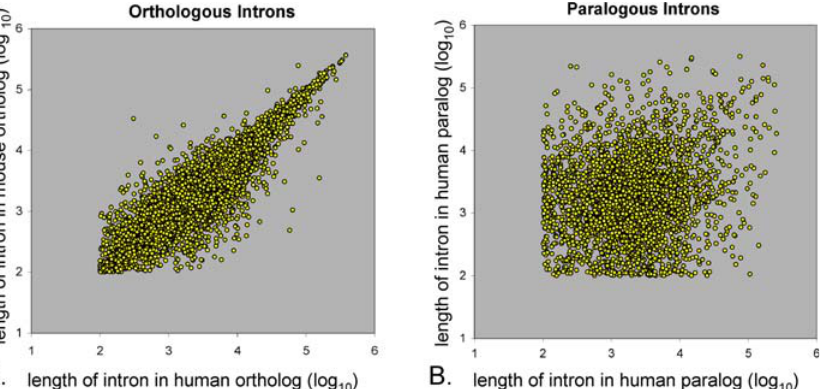
Figure 6. Lengths of Orthologous Introns within a Quartet Are More Correlated than Those of Paralogous Introns (A) Quartet orthologous intron pairs. x -axis, length (log 10 ) of introns in human members of each quartet; y -axis, length (log 10 ) of corresponding orthologous introns in the mouse member of the same quartet. Spearman correlation coefficient: 0.903; p , 0.001. (B) Paralogous introns. x -axis, length (log 10 ) of introns in human members of each quartet; y -axis, length (log 10 ) of corresponding paralogous introns in the other human member of the same quartet. Spearman correlation coefficient: 0.140; p , 0.001. The mouse distributions are essentially identical to their human counterparts. DOI: